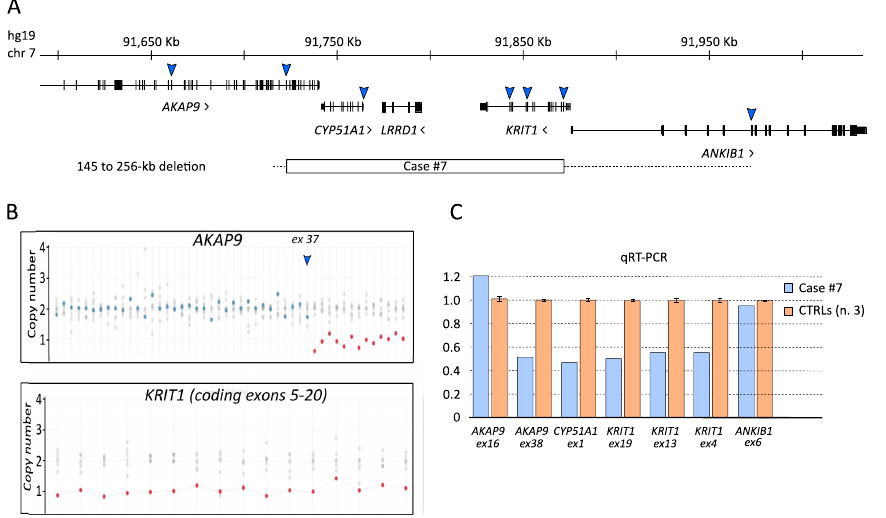
Figure 2. Analysis of the KRIT1 genomic deletion identified by NGS in case #7. ( A ) Screenshot from UCSC genome browser centered on KRIT1 (hg19). Arrows approximately indicate the genomic re- gions analyzed by real-time PCR assays in order to verify the deletion identified by NGS, including its chromosomal mapping and extension. The minimal extension of the identified deletion is indi- cated by a rectangle; the hyphened line indicates a region of uncertainty. ( B ) Exon dosage for AKAP9 and KRIT1 genes obtained by WES data. ( C ) Histogram showing the outcomes of quantitative real- time PCR (qRT-PCR) assays.